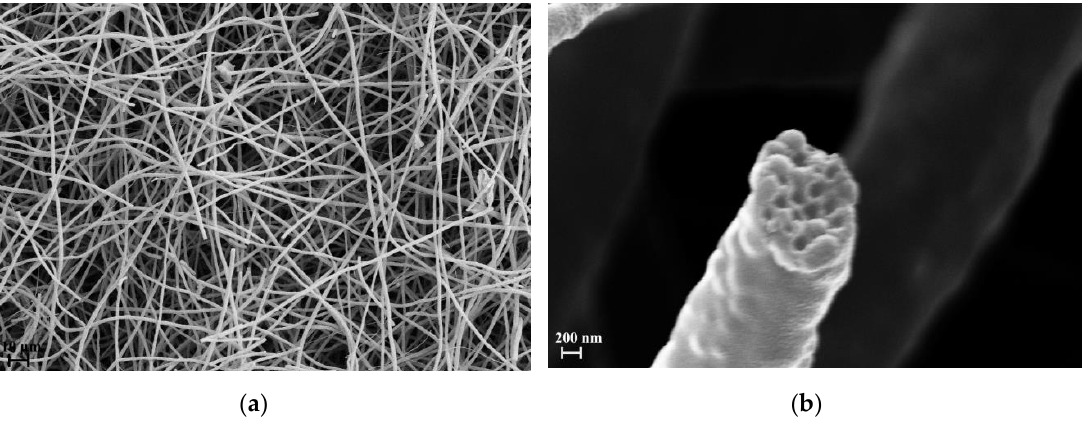
Figure 6. ( a , b ) SEM micrograph of heat treated mat (PVP_SiO 2 HT) at different magnifications.